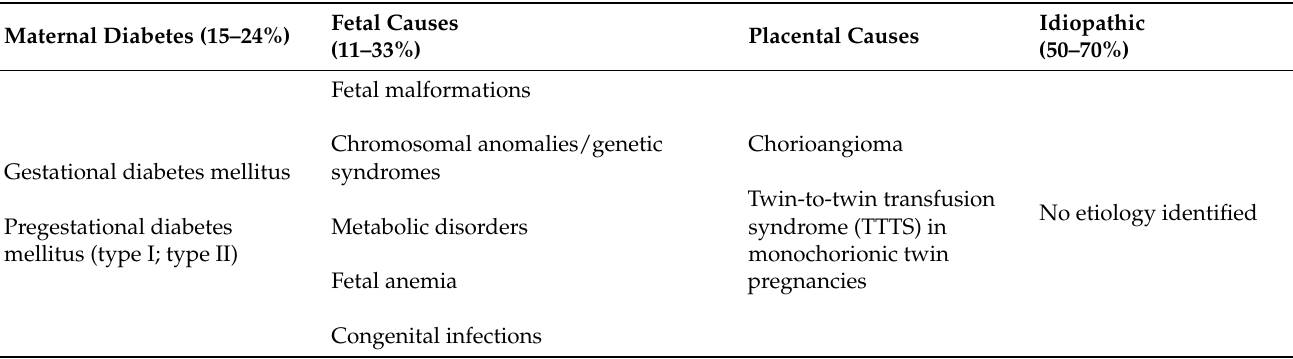
Table 3. Polyhydramnios: etiologies.